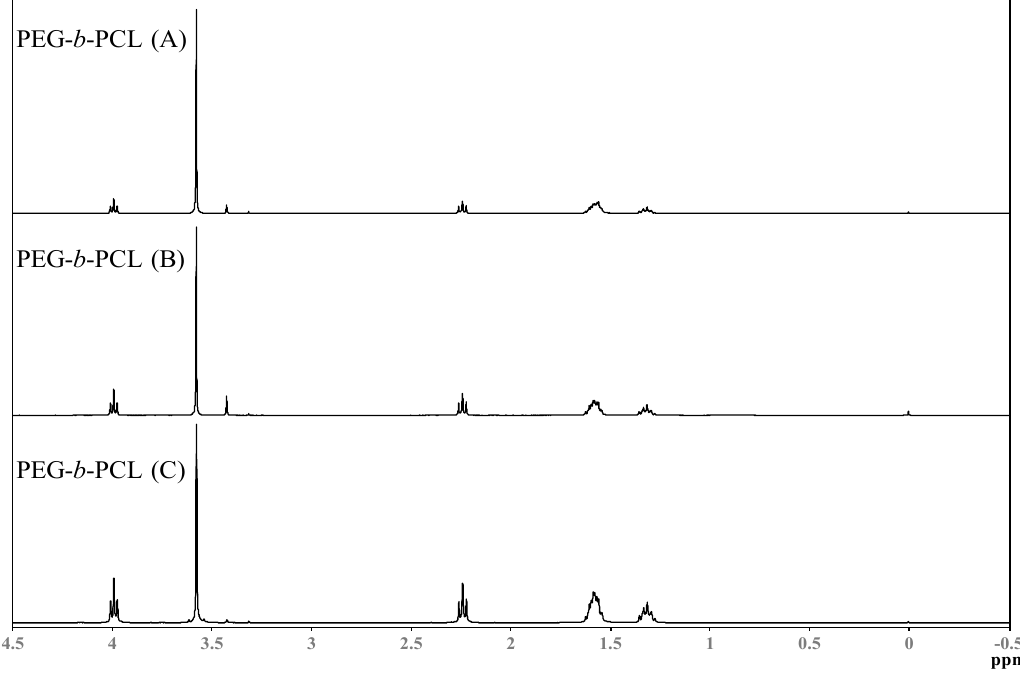
Figure 4. Nuclear Magnetic Resonance Spectroscopy (1H-NMR) spectra for the synthesized PEG- b -PCL copolymers.